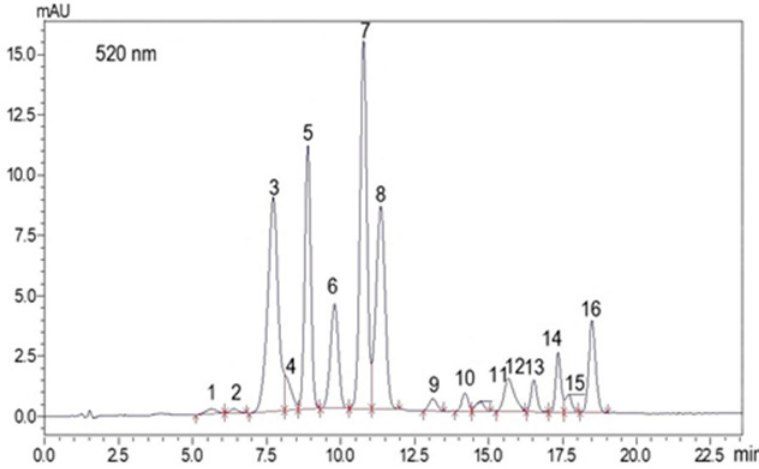
Figure 1. An example of anthocyanins profile of ‘Rondo’: